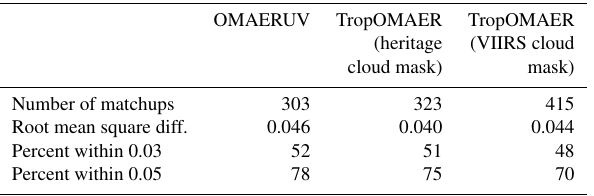
Table 3. Number of coincidences, root mean square difference, and percent of SSA retrievals within 0.03 and 0.05 of AERONET values (column 1) for OMAERUV (column 2), TropOMAER with heritage cloud mask, and TropOMAER with VIIRS cloud mask (column